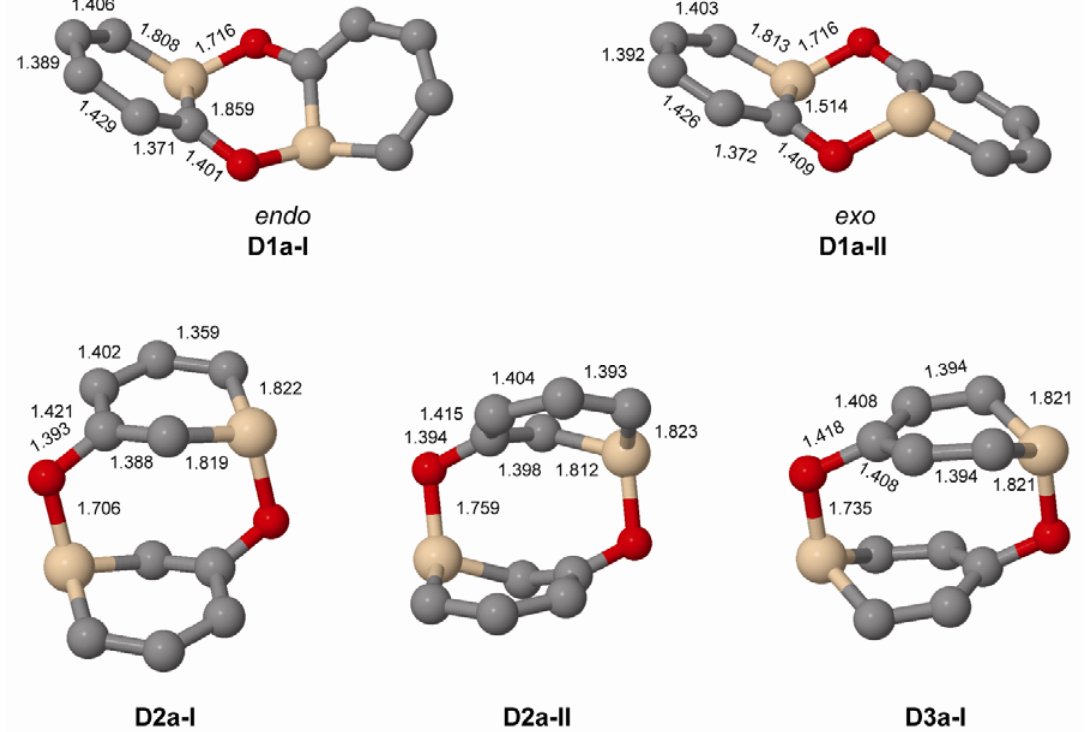
symmetry) calculated 2